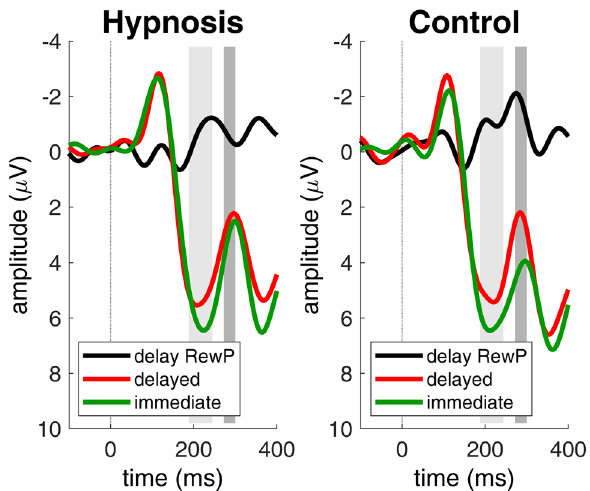
Figure 6. Delay reward positivity with associated ERPs averaged over reward magnitude. Participants showed significantly smaller reward positivity amplitudes in the hypnosis condition compared to the control condition (black lines). The lighter grey area indicates the P2 time window, the darker grey area indicates the delay reward positivity time window. Data were recorded at channel FCz. Negative is plotted up by convention.